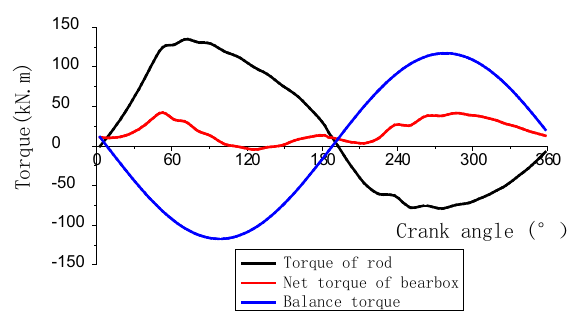
Fig. 6 Torque curve of conventional pumping units (Guo 2015)